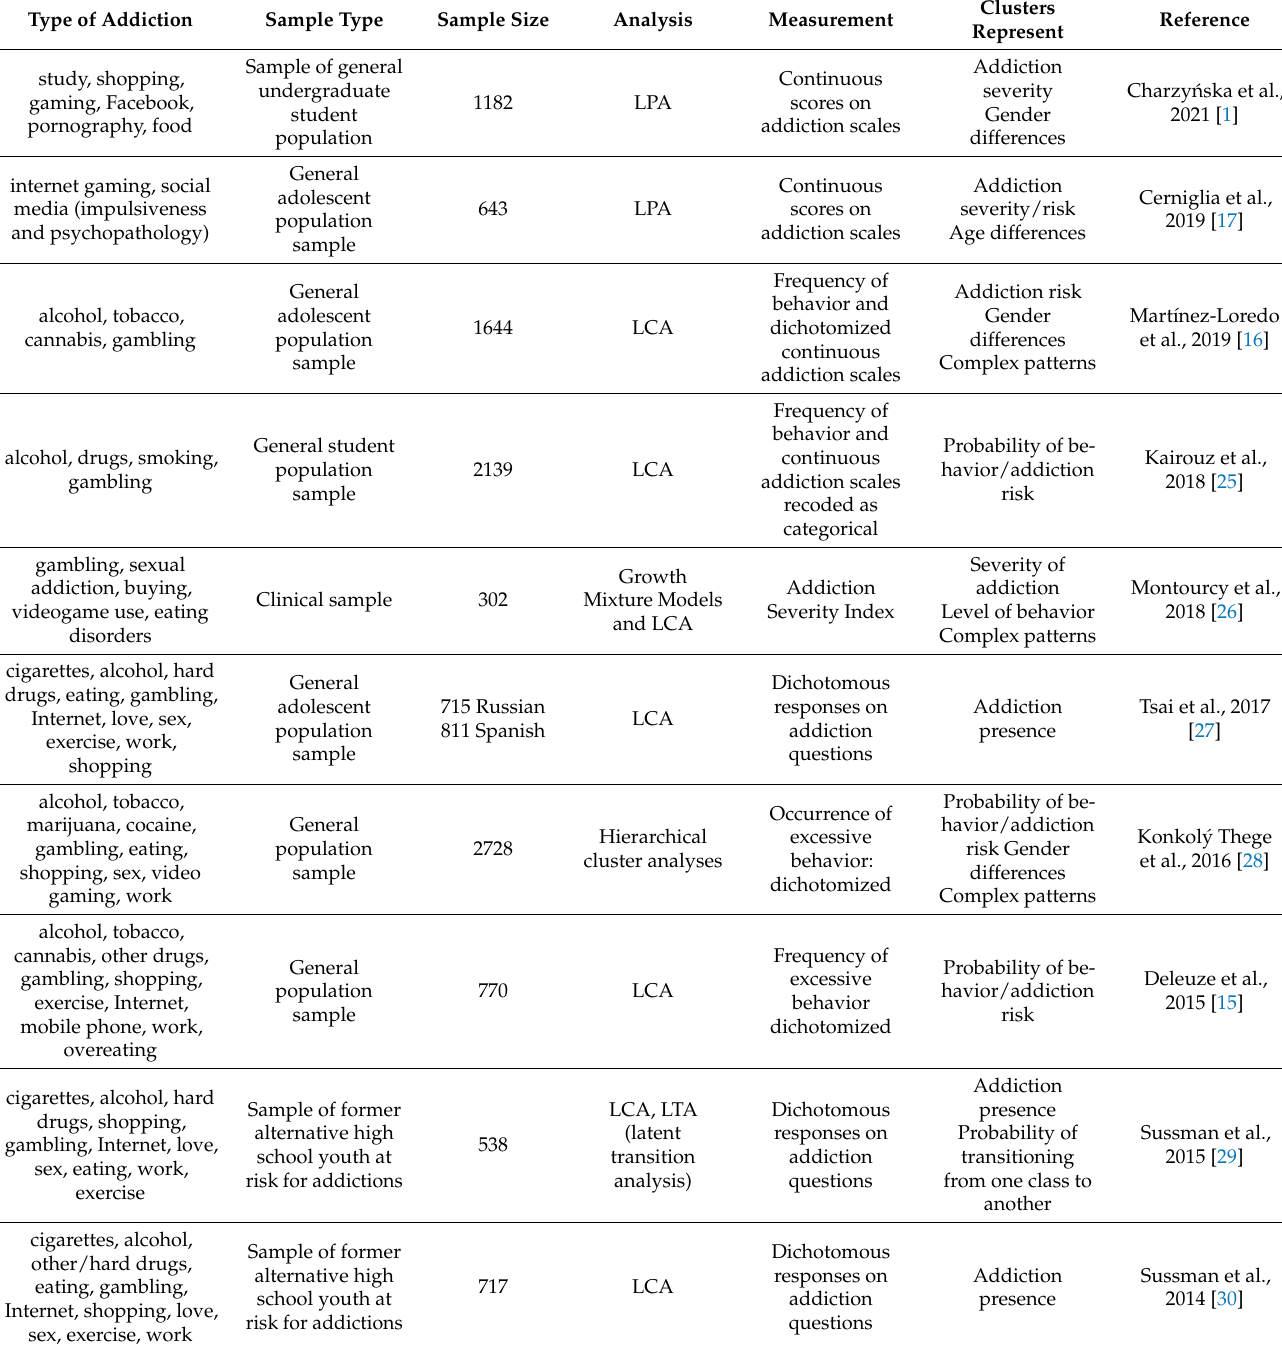
Table 2. Studies Using Person-Centered Analyses of Various Addictive Behaviors (Clusters Identified Based on at Least Two Different